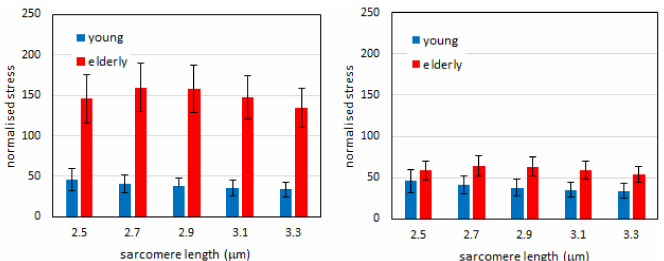
Figure 5. Normalized extra-tension in young and elderly subjects. Left: the same fraction ( α = 3.3% ) of ECM in CSA is considered in the two groups. Right: fraction of ECM (parameter α ) is imposed at 3.3% of fibers CSA in young subjects and 8.2% in elderly subjects. Data are shown as mean value +/ - SEM. The di ff erences between elderly and young subjects at each sarcomere length level of the left histogram are statistically significant ( p < 0.05), while the same di ff erences in the right histogram are